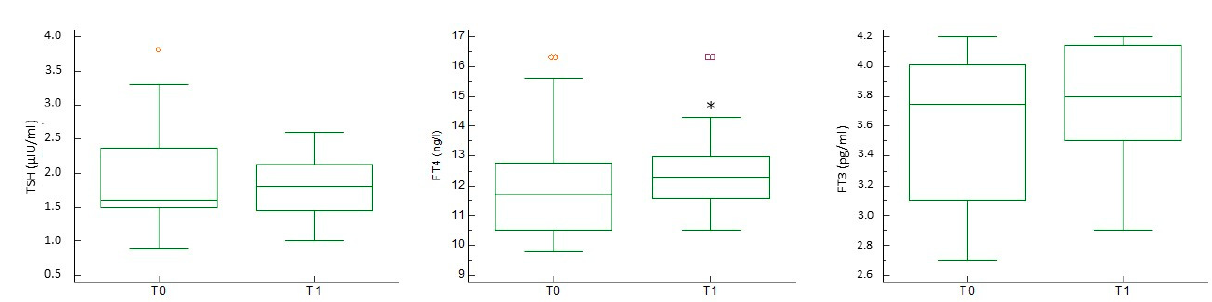
Figure 1. Conventional sperm parameters before and after selenium administration. Sperm concentration, total sperm count, progressive motility, morphology, leukocytes, and sperm DNA fragmentation are shown before (T0) and after (T1) selenium administration. * p < 0.05 vs. T0 (Student’s t -test). Orange and purple symbols represent the maximum values.